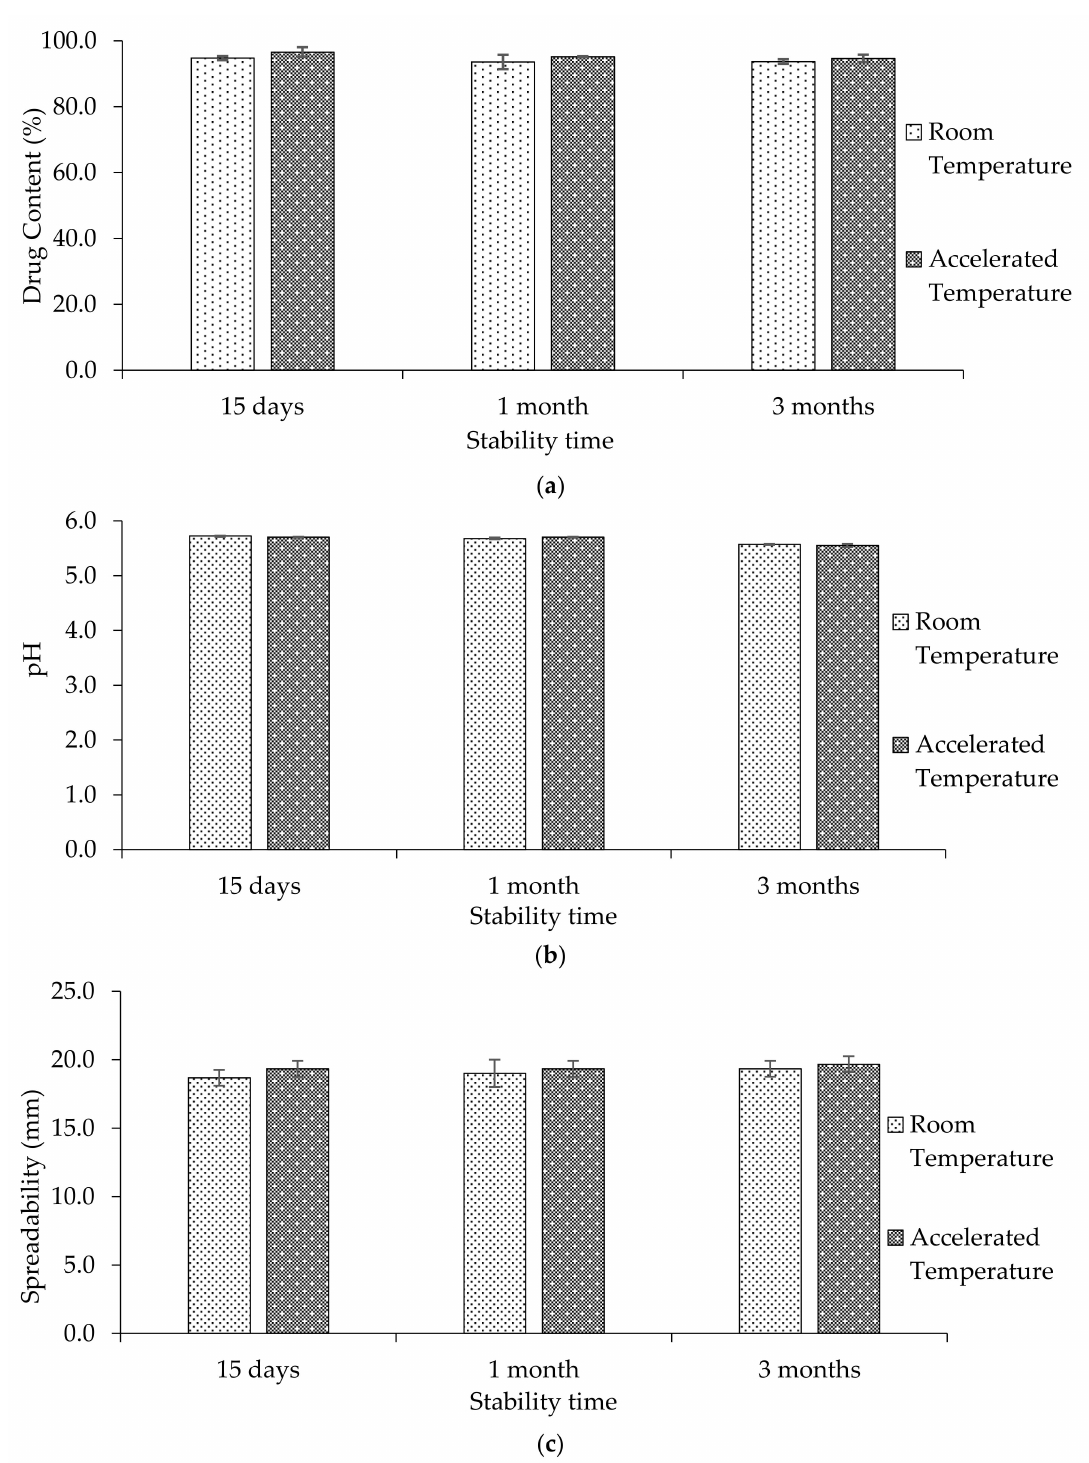
Figure 9. Effect of stability conditions on ( a ) drug content (%), ( b ) pH, and ( c ) spreadability (nm) of the niosomal topical gel ( n = 3, mean ±